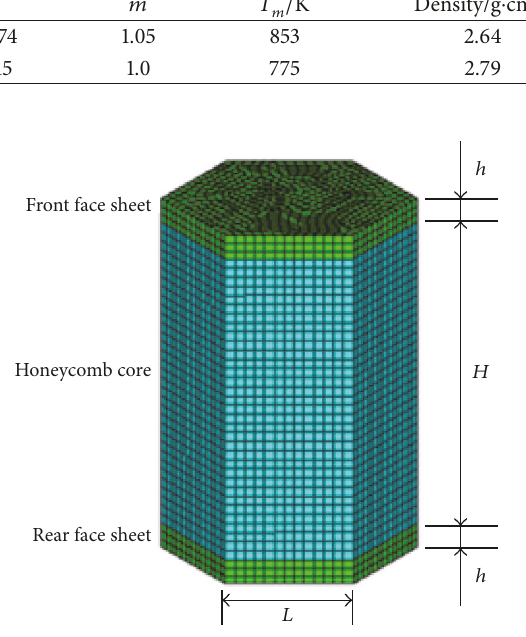
Figure 2: Honeycomb panel